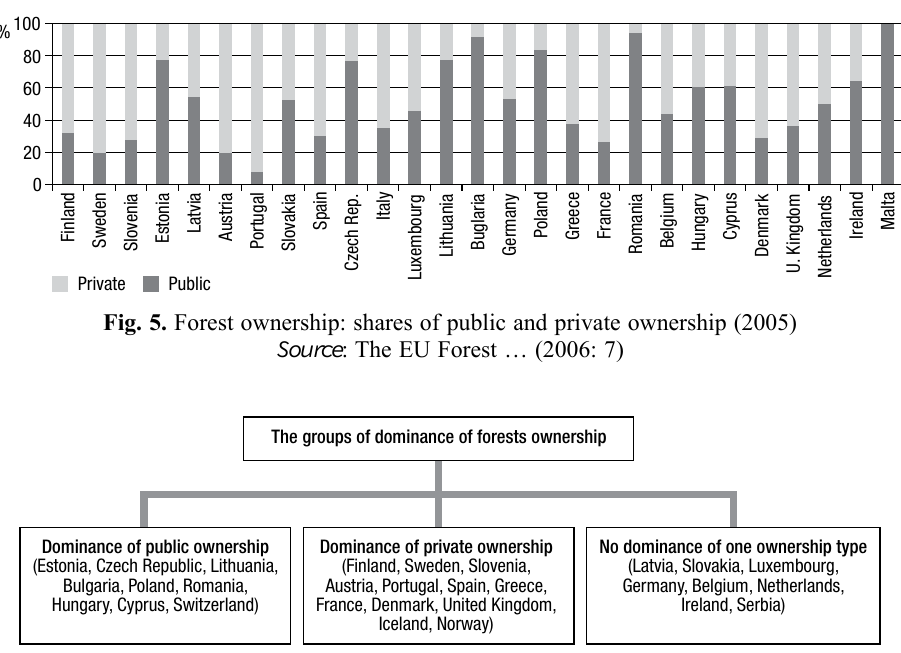
Fig. 6. The EU Member States and other countries according to the groups of dominance of forests ownership structure (2006–2007) Sources : The EU Forest … (2006: 7); Schmithüsen and Hirsch (2009: